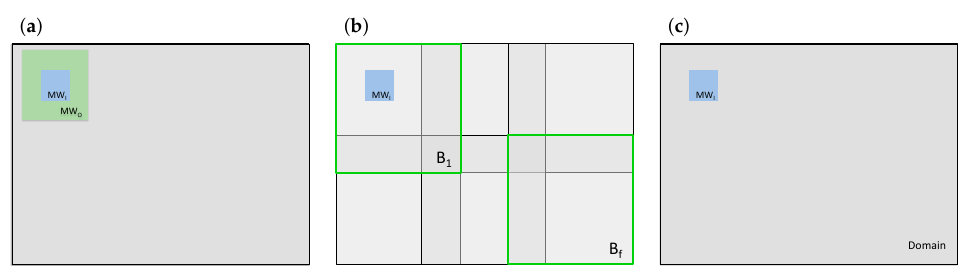
Figure 3. Three nesting schemes, ( a ) inner moving window MW I , u nested inside outer moving window MW O , u , ( b ) MW I , u nested inside blocks B e , and ( c ) MW I , u nested inside the